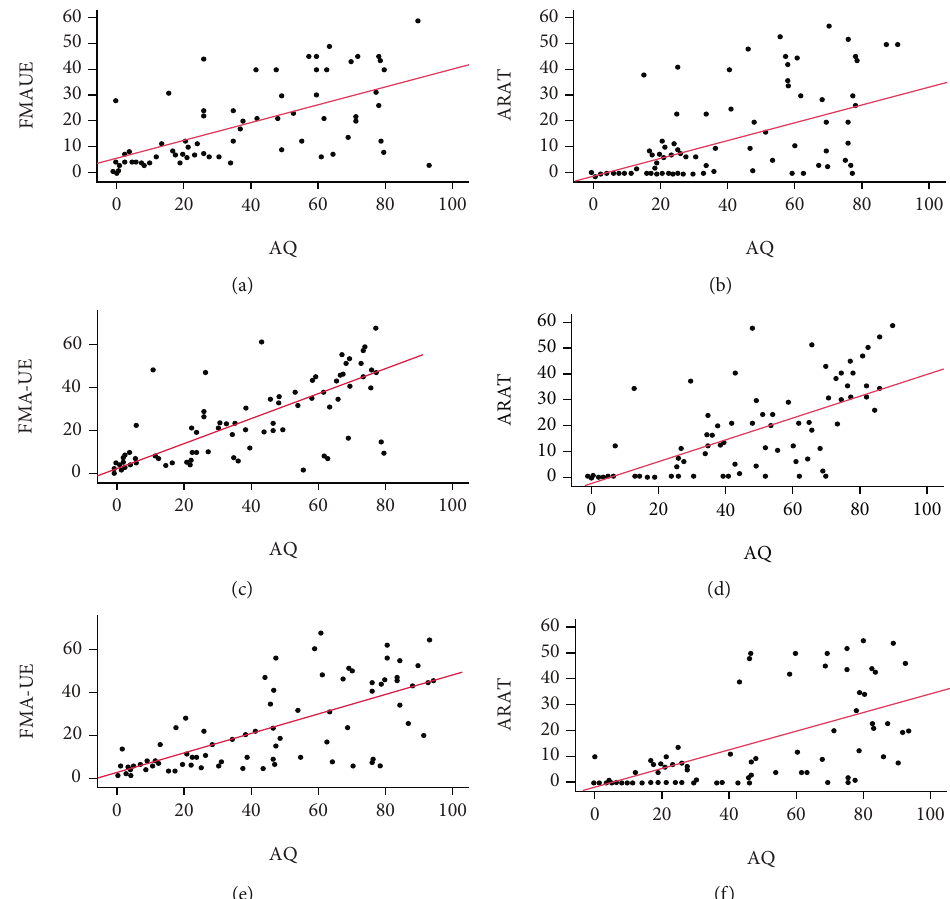
Figure 4: Correlations of independent evaluation scores in di ff erent times from stroke onset. (a, b) The association of AQ with FMA-UE and ARAT in 1-3 months is shown. (c, d) The association of AQ with FMA-UE and ARAT in 4-6 months is shown. (e, f) The correlation of AQ with FMA-UE and ARAT in > 6 months. p < 0 : 001 . FMA-UE indicates the Fugl-Meyer assessment of the upper extremity; ARAT indicates the action research and action test; AQ indicates the Western Aphasia Battery-Aphasia